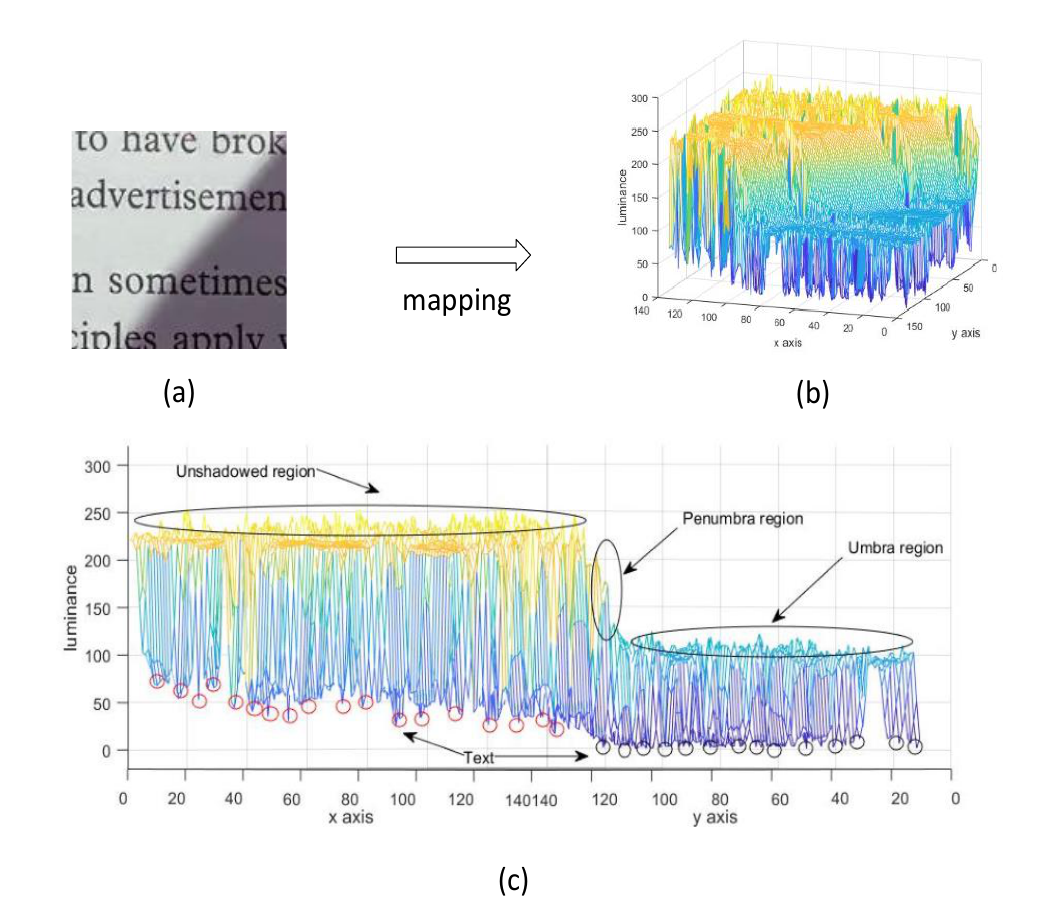
Figure 1. The mapping illustration from one document image with shadows to its topographic structure. ( a ) one document image with shadows, ( b ) the visual topographic structure of image ( a ), ( c ) the clarification of mapping process from image ( a ) to image ( b ): the unshadowed region can be regarded as plateau, umbra as catchment basin, the penumbra as ridge between plateau and basin, and text as the lowest